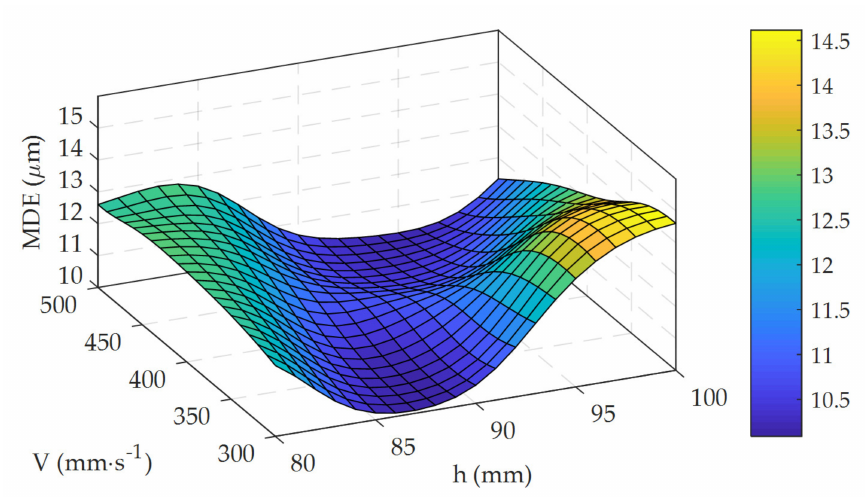
Figure 8. Surface plot of the function MDE (h, V).